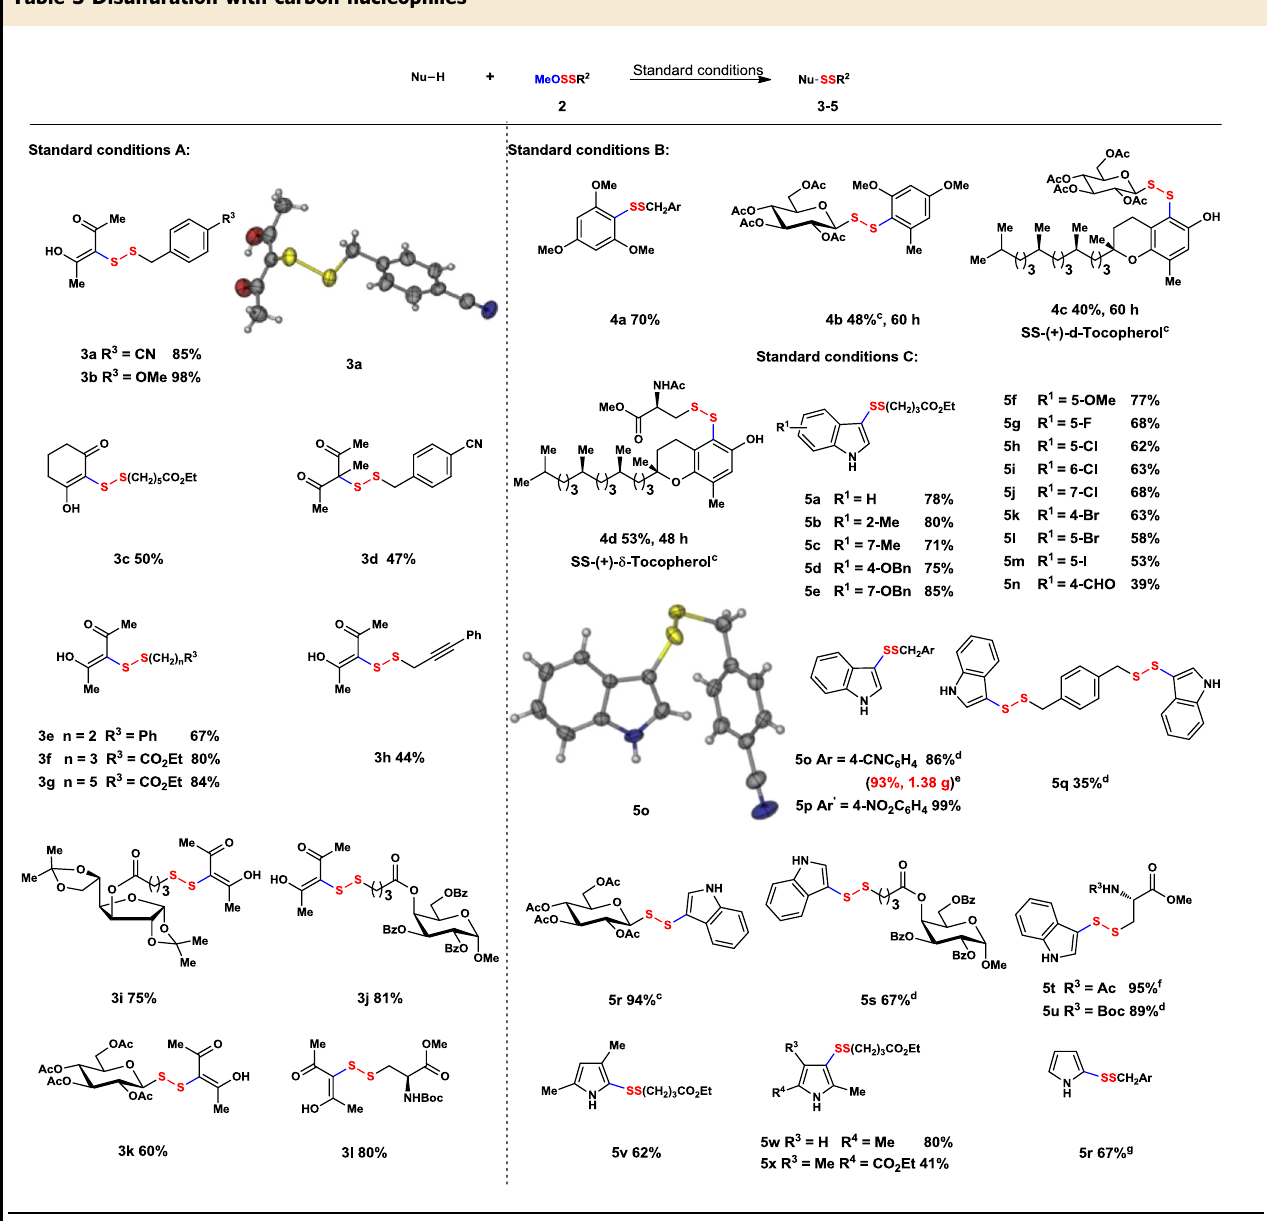
Table 3 Disulfuration with carbon nucleophiles